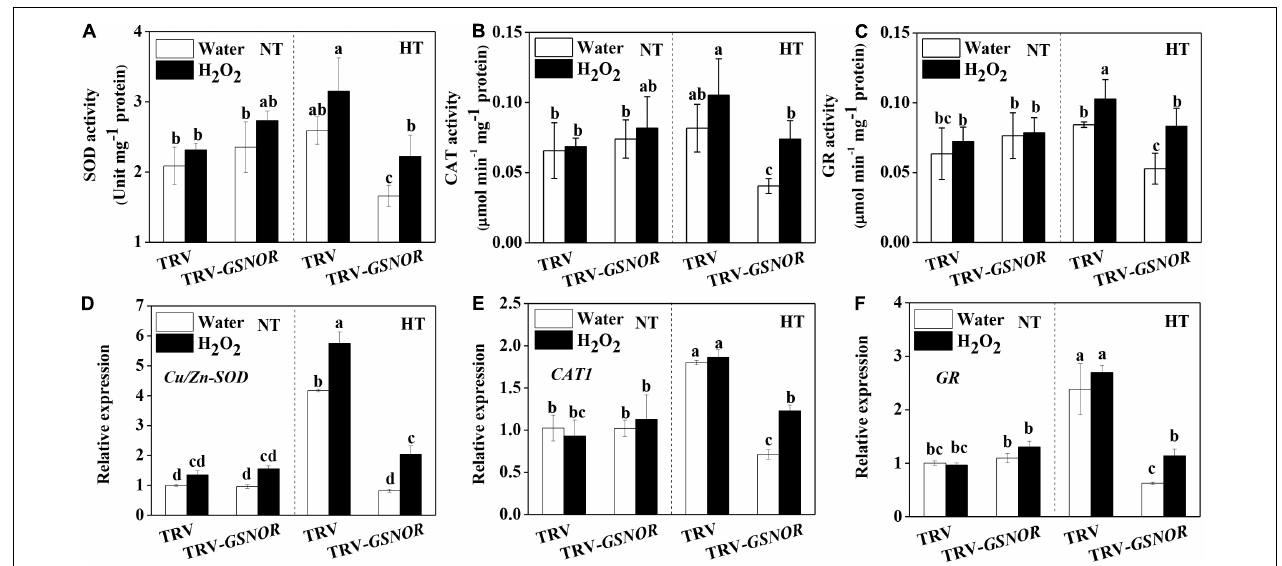
FIGURE 8 | H 2 O 2 recovered the upregulation of antioxidant capacity in response to high temperature in SlGSNOR1 -silenced plants. (A–C) Changes in the activity of antioxidant enzymes, superoxide dismutase (SOD), catalase (CAT), and glutathione reductase (GR). (D–F) Changes in the relative transcript levels of antioxidant genes, Cu/Zn-SOD , CAT , and GR . Plants in the five-leaf stage were exposed 24 h to high temperature (42 ◦ C/38 ◦ C) or normal temperature (21 ◦ C/16 ◦ C). Data are means of three to five replicates ( ± SD). NT, normal temperature; HT, high temperature.